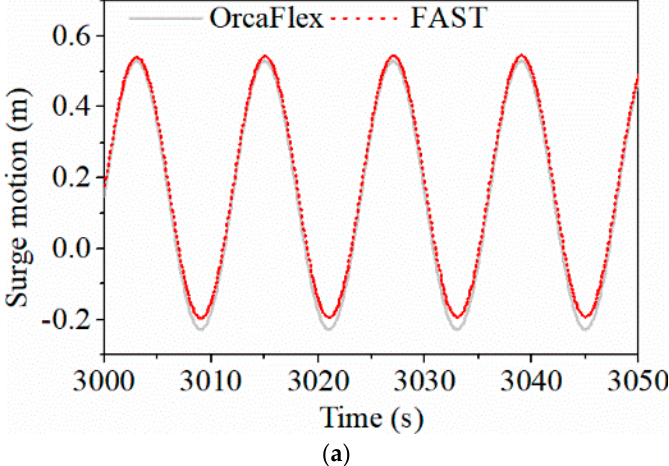
Figure 10. Numerical model and equivalent drag coefficients for the parked condition of turbines.